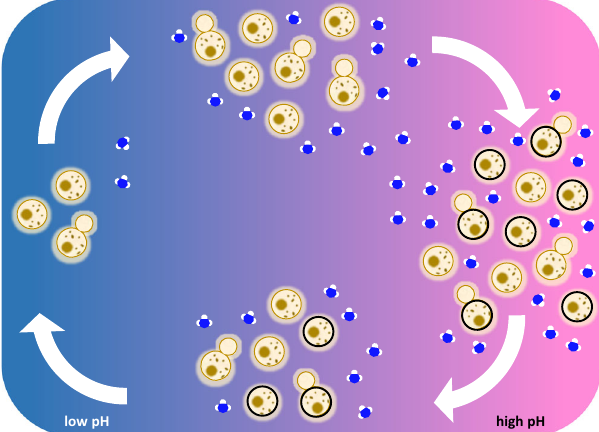
Fig. 6 | Production ofammonia and melanin are inversely regulatedthrough a feedback mechanism. Replication of C. neoformans is favored at low pH but as population density increases, urease-mediated release of ammonia gas also increases to produce a more alkaline environment. The combination of enhanced melanization and slower replication at high pH prolongs persistence of crypto- coccal cells within phagosomes to increase brain dissemination through a Trojan horse mechanism. Melanin deposition in the cell wall provides a feedback mechanism by impeding release of urease-carrying extracellular vesicles to decrease ammonia levels and restore optimal growth pH. Faster growth rates are expected to increase the incidence of lytic release from phagocytes to favor tra- versal of free yeast cells across the blood-brain barrier.